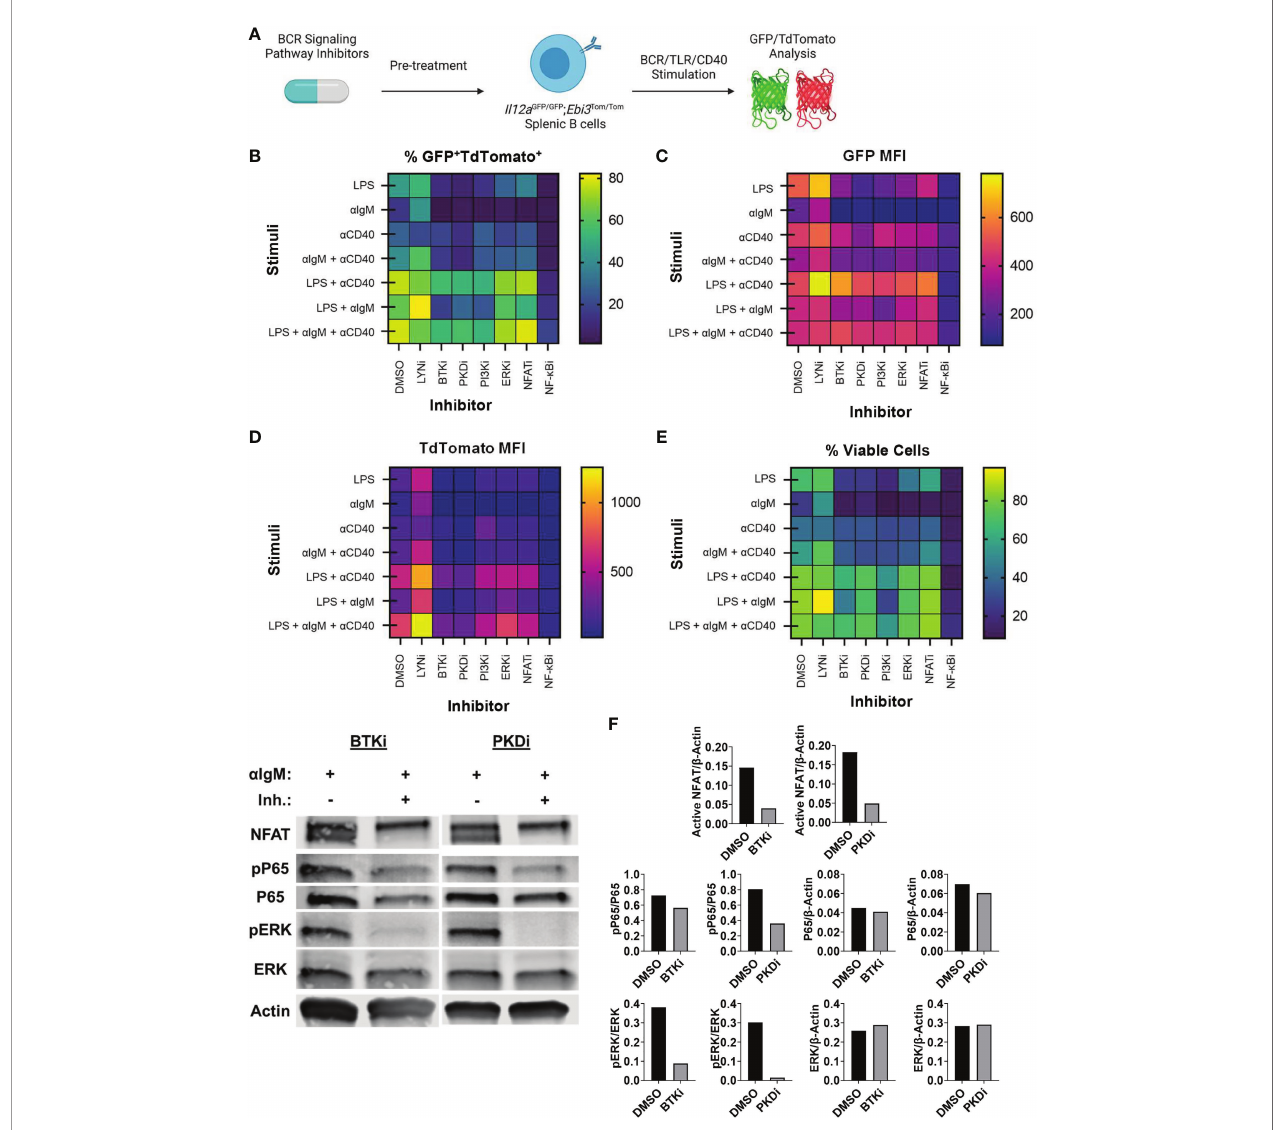
FIGURE 4 | Identi fi cation of BCR pathway signaling molecules that govern IL-35 expression. (A) Heatmap displaying frequency of GFP + TdTomato + B cells from all stimulation conditions and inhibitors 48 hours after stimulation/inhibition. N=3 per condition. Experiment repeated 2 times. (B) Heatmap displaying frequency of viable B cells from all stimulation conditions and inhibitors 48 hours after stimulation/inhibition. N=3 per condition. Experiment repeated 2 times. (C) Heatmap displaying TdTomato mean fl uorescent intensity (MFI) from all stimulation conditions and inhibitors 48 hours after stimulation/inhibition. N=3 per condition. Experiment repeated 2 times. (D) Heatmap displaying GFP mean fl uorescent intensity (MFI) from all stimulation conditions and inhibitors 48 hours after stimulation/inhibition. N=3 per condition. Experiment repeated 2 times. (E) Western immunoblots of WT splenic B cells treated with DMSO, BTKi (5uM), or PKDi (10uM) for 30 minutes followed by stimulation with aIgM (10µg/mL). 30ug of total protein loaded per lane. (F) Quanti fi cation of immunoblots in (E)